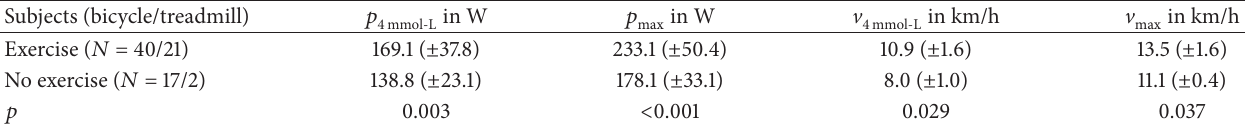
Table 3: Comparison of fitness data between sporting and nonsporting military executives. All data are presented as mean ± standard deviation.